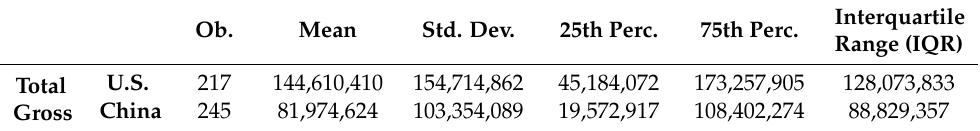
Table 2. Summary statistics of the total lifetime grosses in the United States and China. Ob. Mean Std. Dev. 25th Perc. 75th Perc.